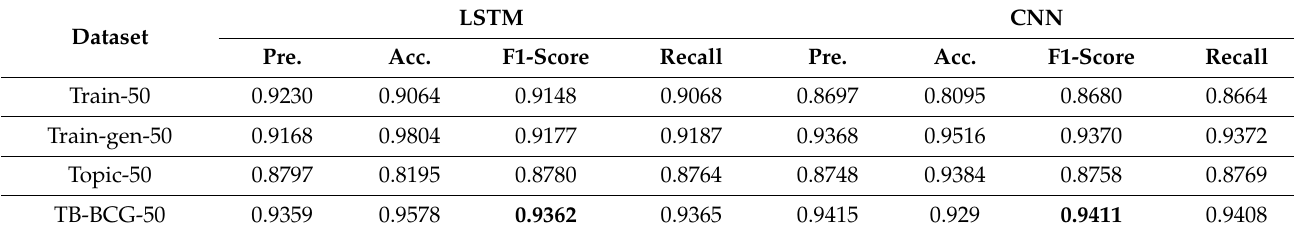
Table 8. Experimental result of 50% dataset.